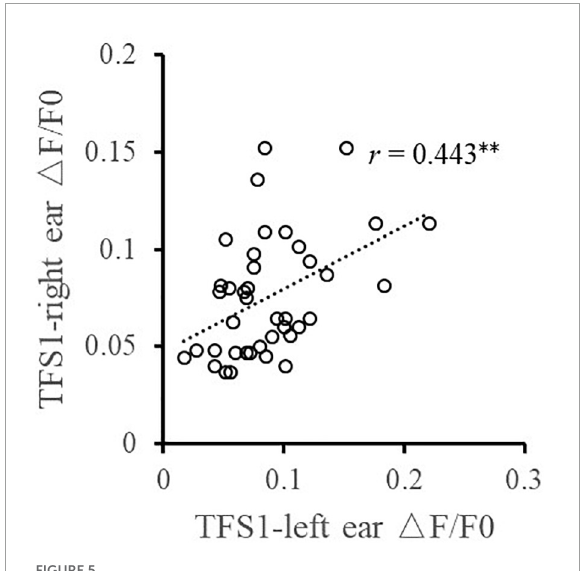
FIGURE5 Illustration of the correlation analysis of the TFS1 scores of the left and right ears. ∗∗ p < 0.01.